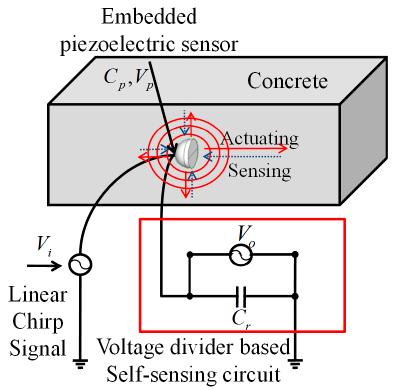
Figure 3. Schematic diagram of self-sensing based impedance measurement.